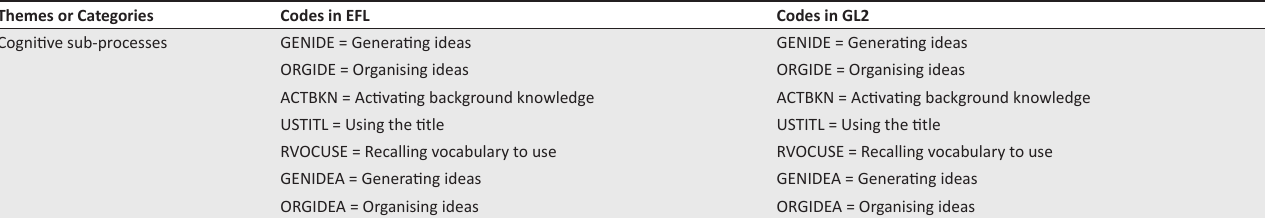
TABLE 1: Categories and codes of the thematic strand ‘prewriting stage’. Themes or